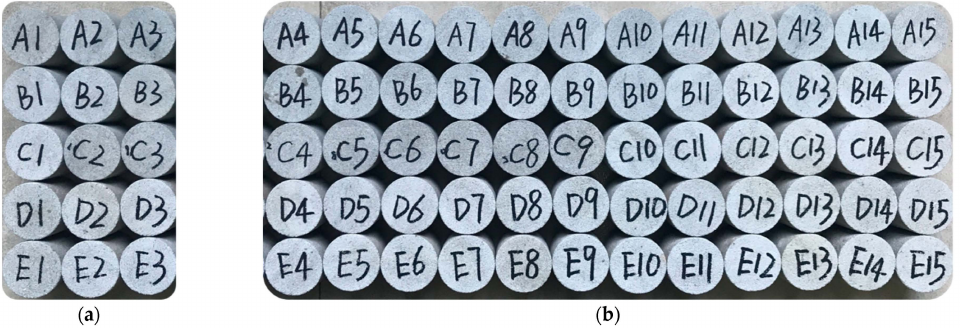
Figure 2. Rock Specimens: ( a ) specimens for uniaxial compression tests; ( b ) specimens for triaxial compression tests.